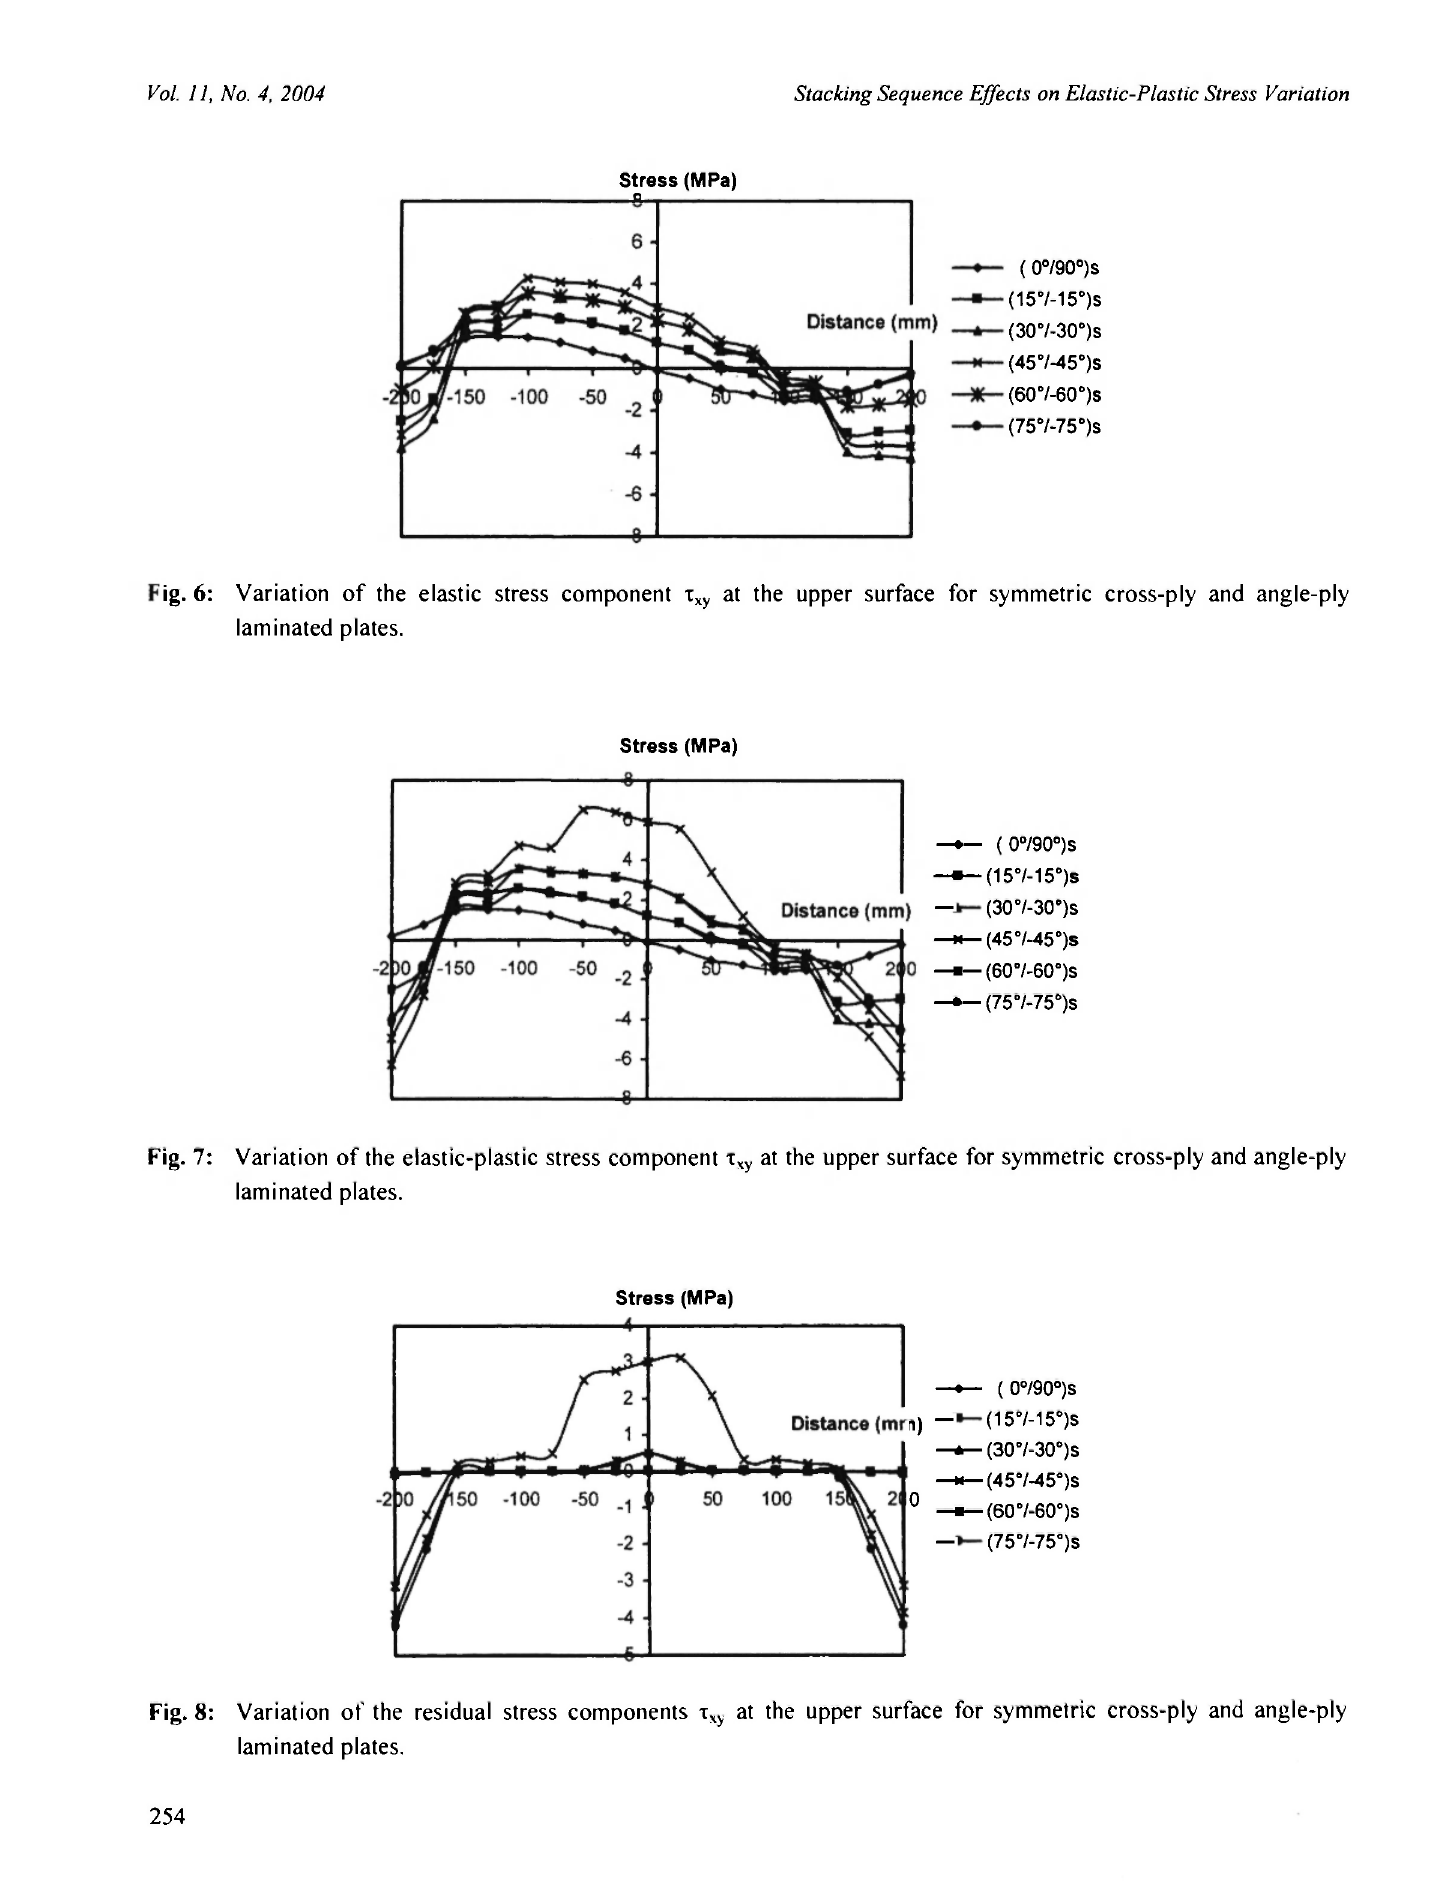
Fig. 8: Variation of the residual stress components x xy at the upper surface for symmetric cross-ply and angle-ply laminated plates.